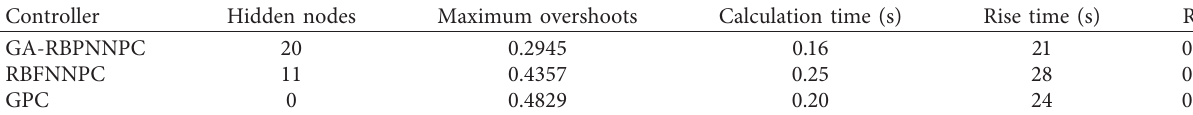
Table 3: Comparison of the performance of different controllers.